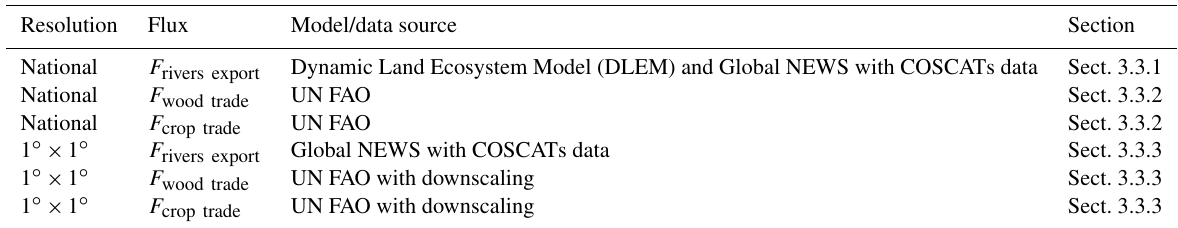
Table 3. Data sources for lateral flux